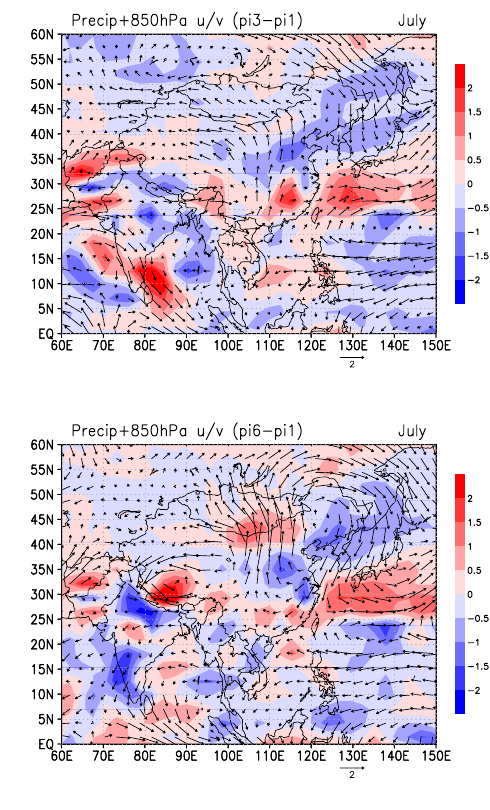
Fig. 16. Same as Fig. 15 but for